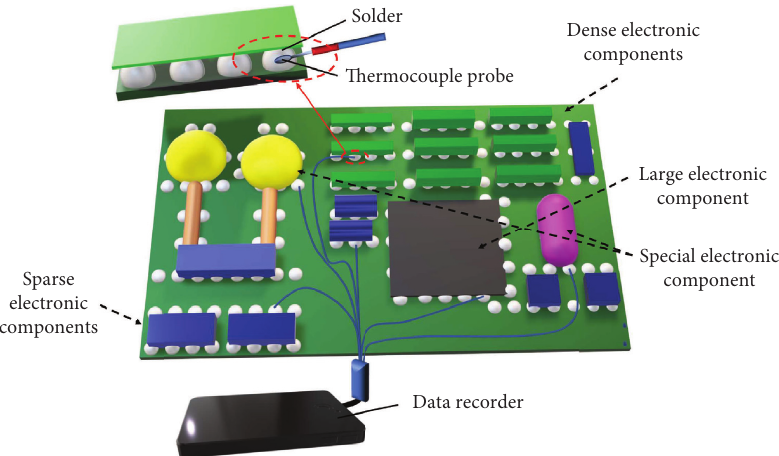
Figure 2: Temperature measurement of the soldering area.